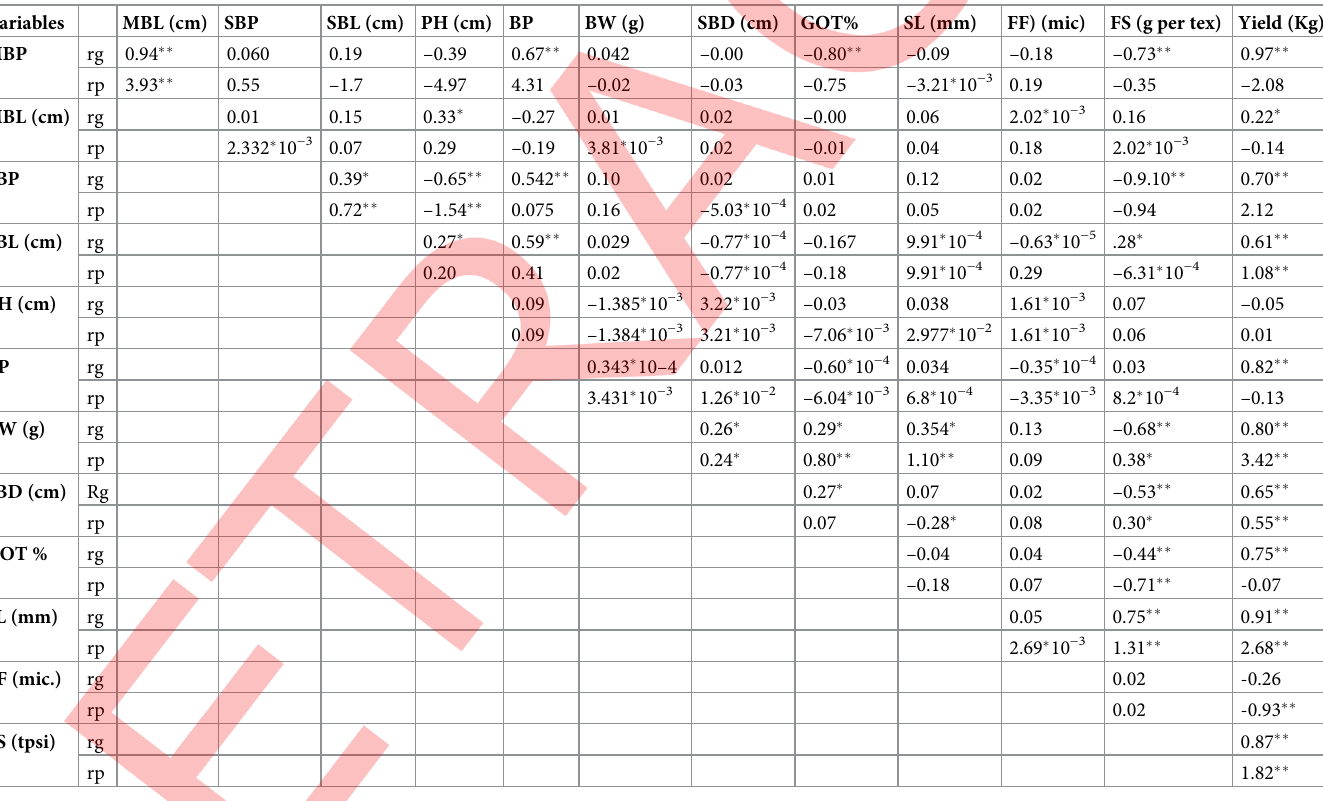
Table 2. Estimated genetic and phenotypic coefficients of correlation for various agronomic and fiber traits towards yield of upland cotton.